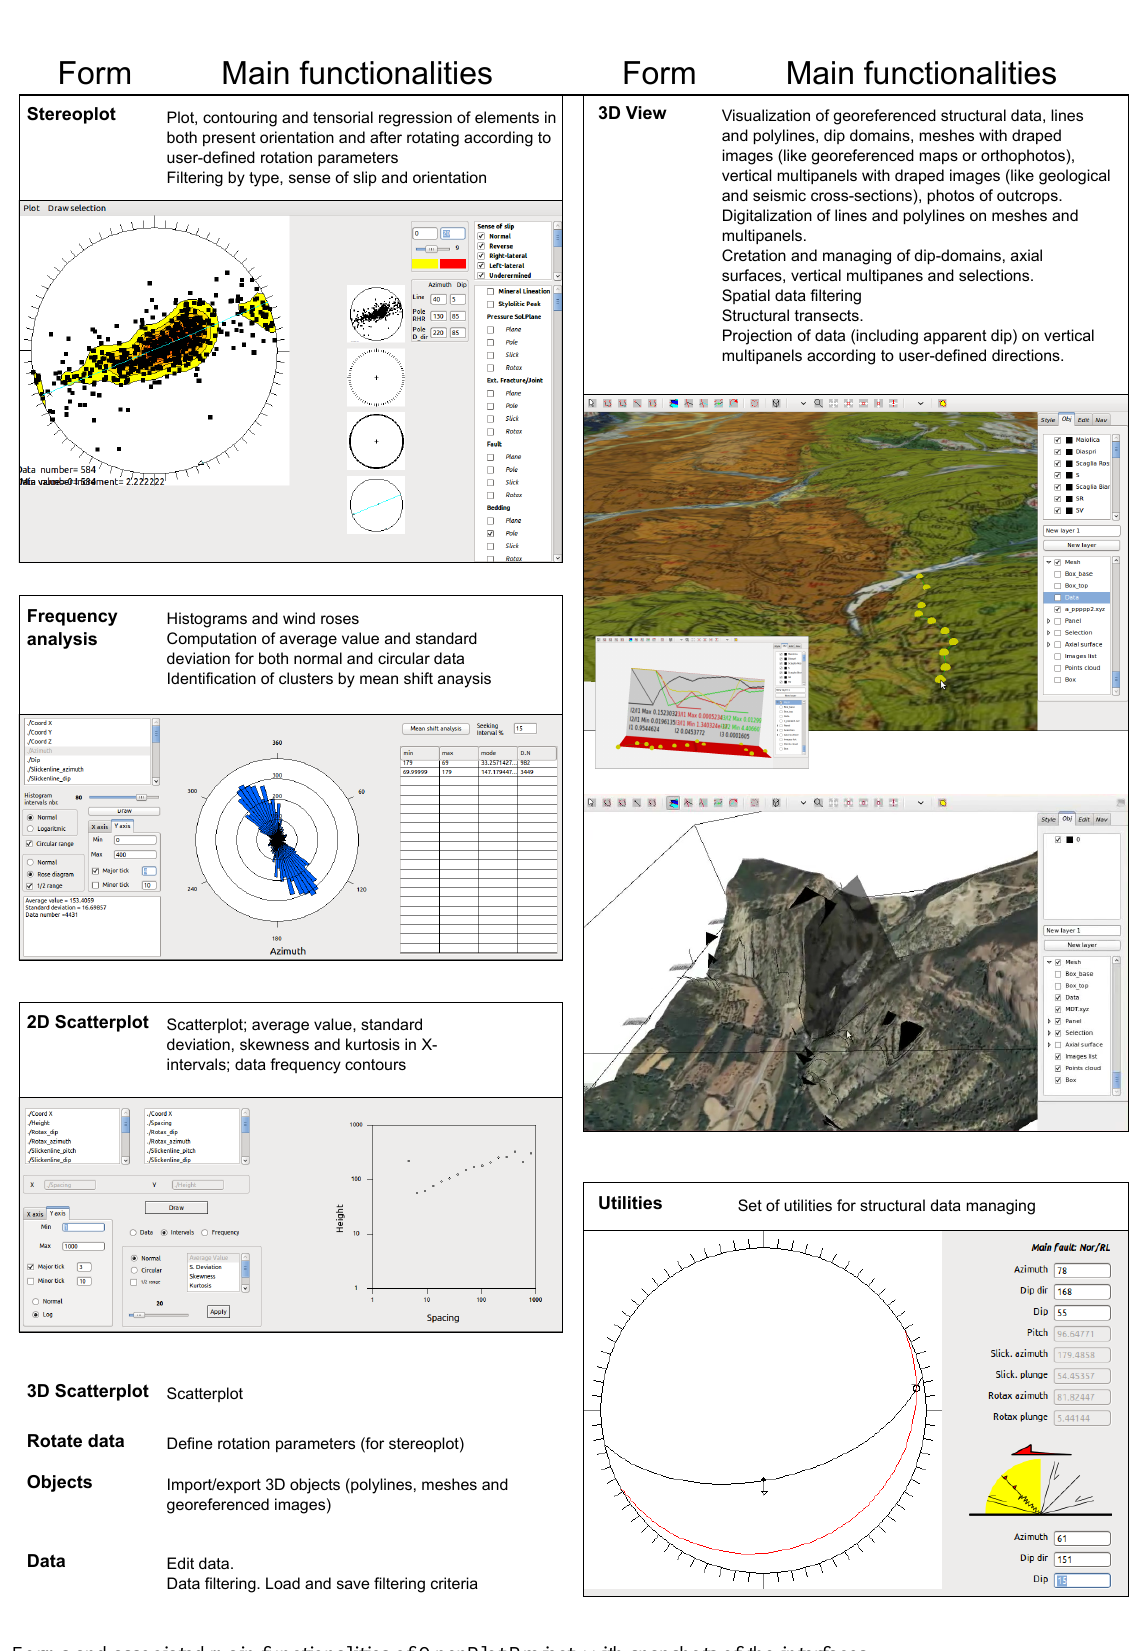
Fig. 1. Forms and associated main functionalities of OpenPlot Project, with snapshots of the interfaces.